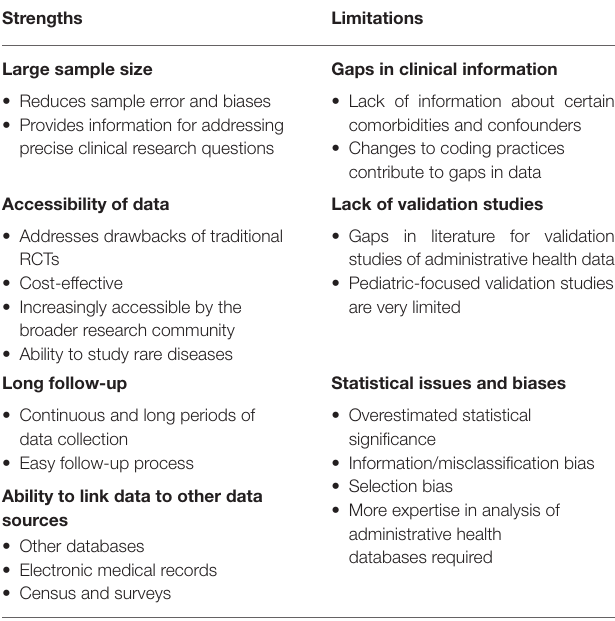
TABLE 1 | Summary of strengths and limitations of administrative health